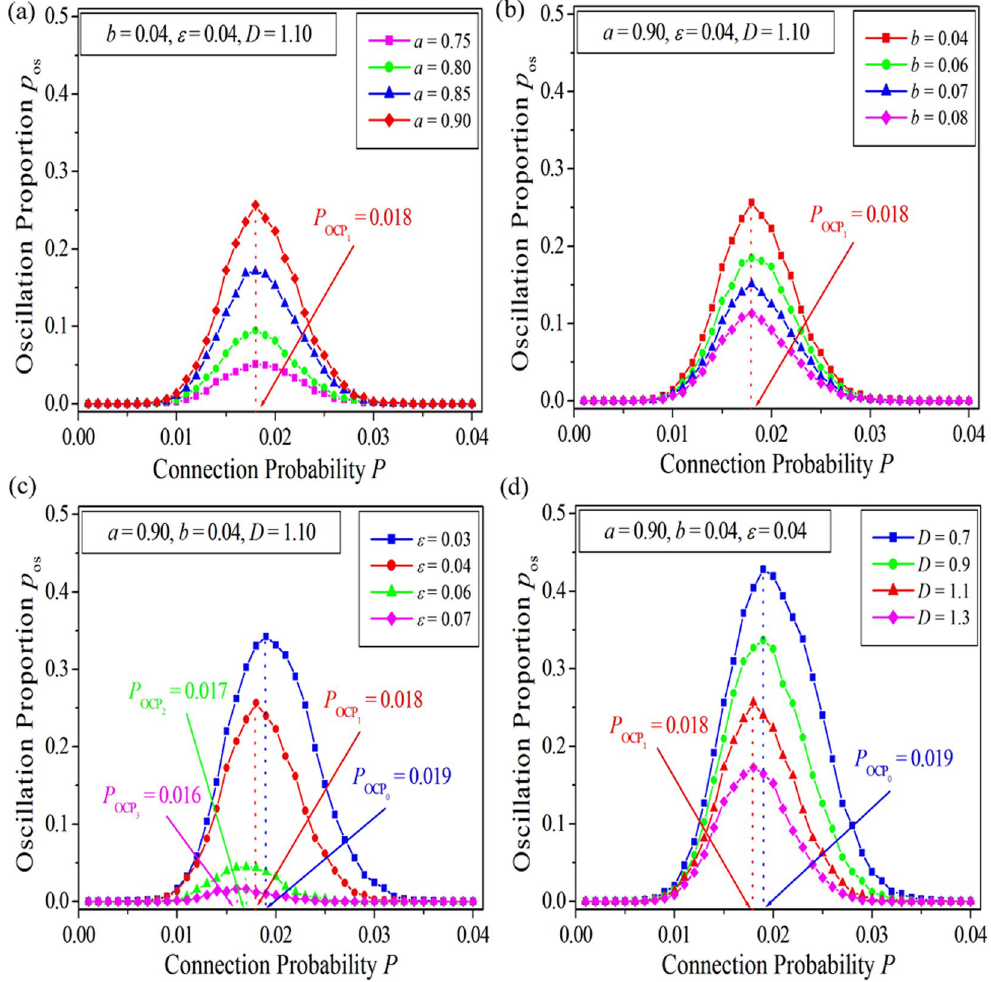
Figure 1. The dependence of the oscillation proportion p os on the connection probability P at different system parameters a ( a ), b ( b ), ε ( c ) and D ( d ) in excitable Erdös-Rényi random networks (EERRNs). Other parameters are fixed and marked in the corresponding panels. The system size is selected as N = 100. The oscillation os proportion is defined as = p N . Here N ALL is the total number of numerical simulations starting from N os ALL random initial conditions for each set of parameters, and N os is the number of self-sustained oscillations counted in N ALL dynamical processes. For each set of parameters, five thousand independent numerical simulations are performed (i.e., N ALL = 5000). The optimal connection probabilities (OCPs) P OCP for supporting self-sustained oscillations in EERRNs at different system parameters are